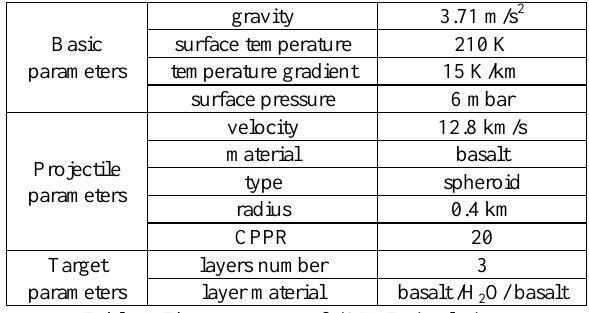
basalt /H 2 O/ basalt